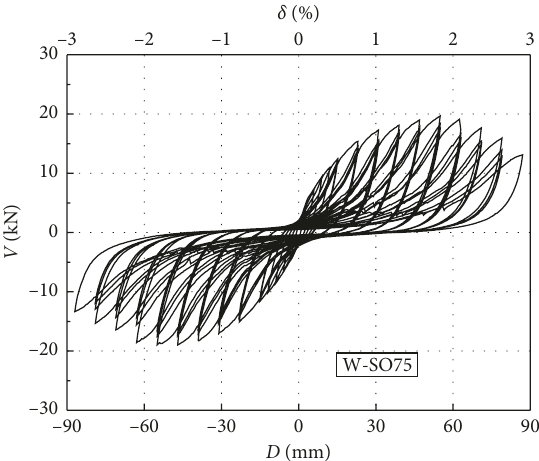
Figure 5: Typical hysteresis curves of CFS shear walls (specimen